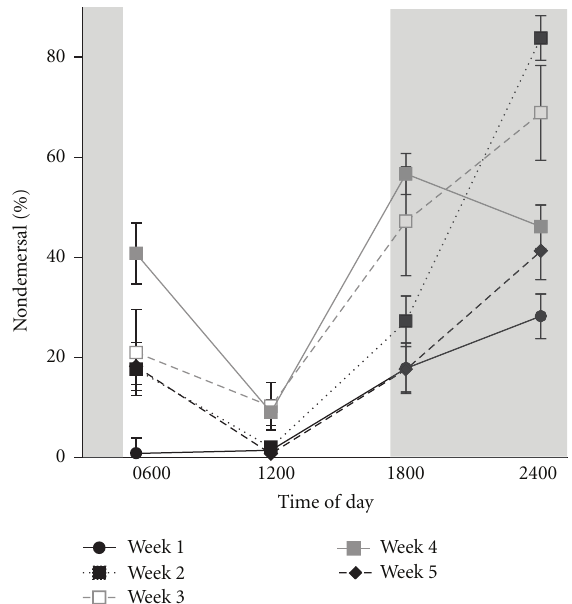
Figure 1: Percentage of Kelletia kelletii larvae that were nondemer- sal throughout a 24-hour period as a function of ontogeny (weeks 1–5) in 8d × 15 hcm culturing columns ( n = 5). Grey shading indicates lights o ff . Error bars represent ± 1 SE.